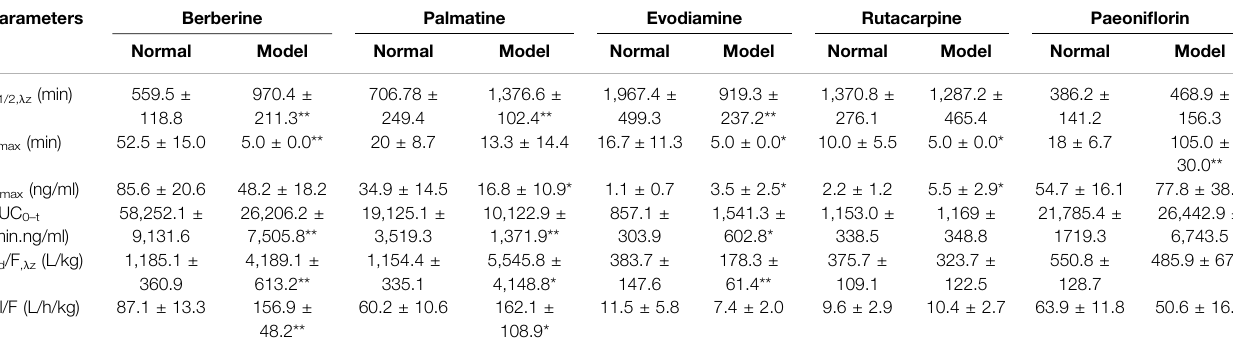
TABLE 4 | Pharmacokinetic parameters of berberine, palmatine, Evodiamine, rutacarpine, and paeoni fl orin in rat after multiple doses of oral administration of WJW Extract (629.6 mg/kg) with the equivalent dose of 88.4 mg/kg, 21.1 mg/kg, 0.22 mg/kg, 0.28 mg/kg, 25.1 mg/kg for berberine, palmatine, evodiamine, rutacarpine, and paeoni fl orin, respectively (mean ± SD, n =